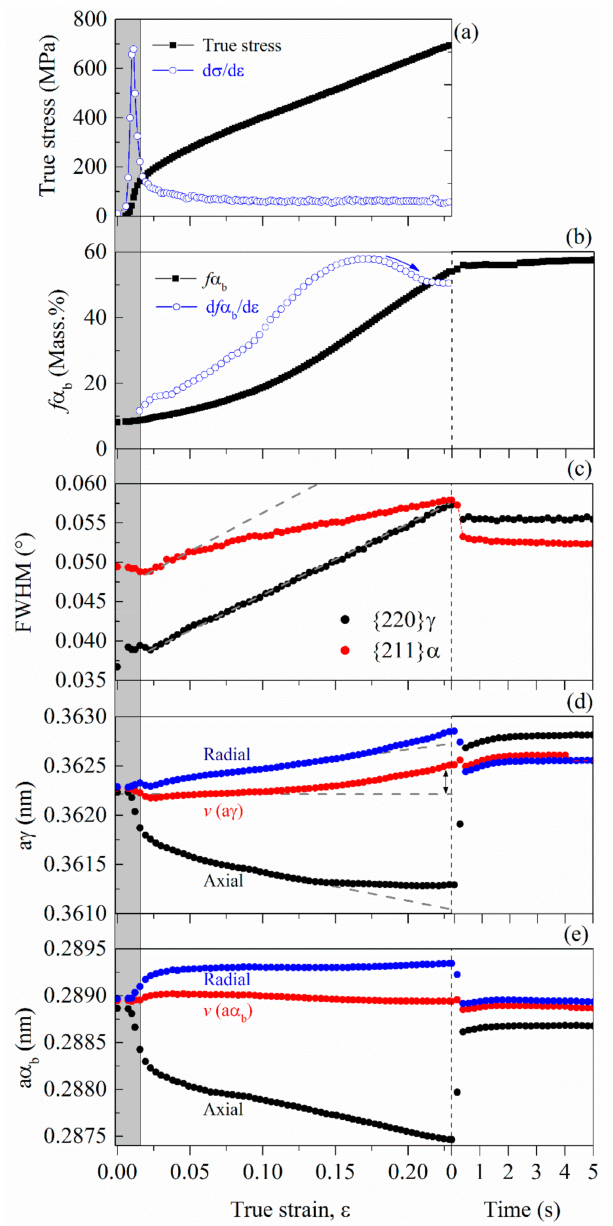
Figure 2. Microstructural evolution of DT ( γ → α b) at 500 ◦ C as a function of strain and after unloading as a function of time—( a ) macroscopic stress; ( b ) transformed volume fraction of bainitic ferrite- f α b , ( c ) full width at half maximum (FWHM) of the {220} γ and {211} α diffraction peaks, ( d ) austenite lattice parameter-a γ , and ( e ) bainitic ferrite lattice parameter-a α b . “ v (a γ )” and “ v (a α b )” denote the lattice parameter of austenite and bainite considering the Poisson’s ratio, respectively. (Color figure